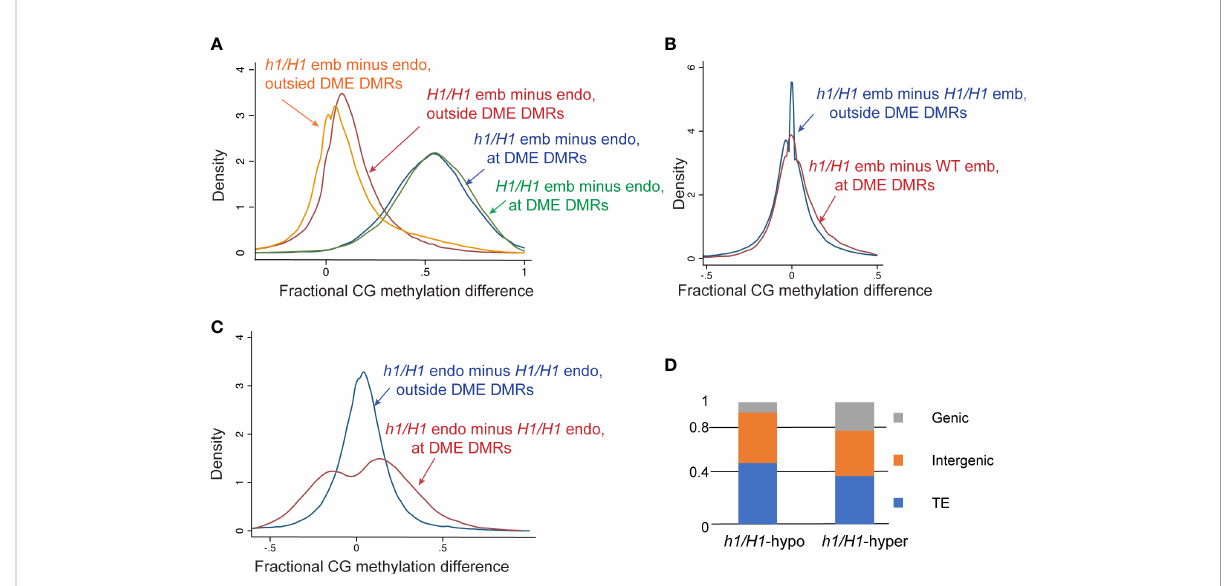
FIGURE 3 Methylome analysis of embryo and endosperm derived from the maternal wild type or h1 mutant crossed with L er pollen. (A) Kernel density plots of CG methylation difference between embryo and endosperm (embryo minus endosperm) in wild type H1/H1 (blue and magenta traces) or mutant h1/H1 endosperm (green and orange traces). Methylated loci were grouped into canonical DME DMRs (50-bp windows, N=36281, blue and green traces) and outside DMR loci (N=338297, magenta and orange traces). (B) Kernel density plots of CG methylation difference between H1/H1 and h1/ H1 embryo in DME DMRs (magenta) and non-DMR loci (blue). (C) Kernel density plots of CG methylation difference between H1/H1 and h1/H1 endosperm in DME DMRs (magenta) and non-DMR loci (blue). (D) Percent distribution of the three different genomic features in canonical DME DMRs that loose ( h1/H1 -hypo) or gain ( h1/H1 -hyper) in h1/H1 endosperm compared with wild